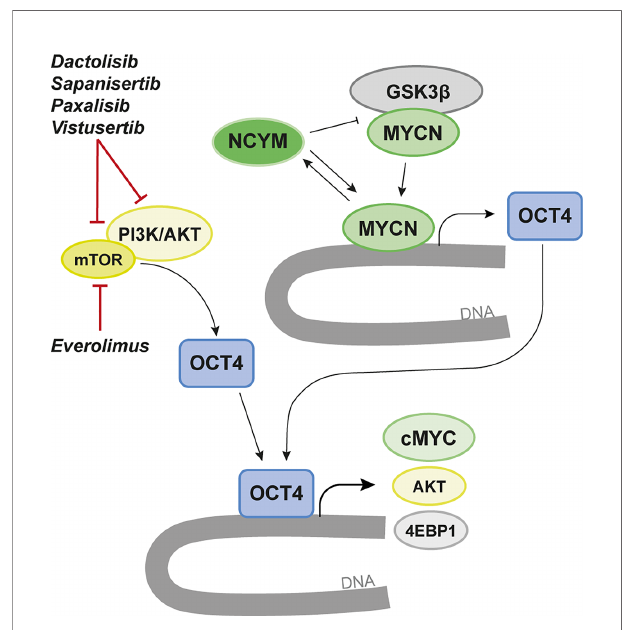
FIGURE 3 | Targeting of MYCN-dependency via the OCT4/mTOR Axis. MYCN transcriptionally regulates OCT4 and promotes increased OCT4 levels that correlate with poor prognosis in various brain tumor entities. OCT4 has been found to form a positive regulatory loop that induces increased protein stability of MYCN by increasing the levels of its cis-antisense gene NCYM. In parallel, mTOR/PI3K/AKT promotes OCT4 levels in both normal and malignant cells. Here AKT is known to activate OCT4 by phosphorylation leading to OCT4-dependent upregulation of 4EBP1 and cMYC but also to a positive loop that again promotes AKT expression. We propose a strategy where targeting of OCT4 using various mTOR/PI3K inhibitors could regulate MYCN and suppress MYCN-dependent brain cancer. A few selected inhibitors tested in the brain tumor papers discussed in the review are